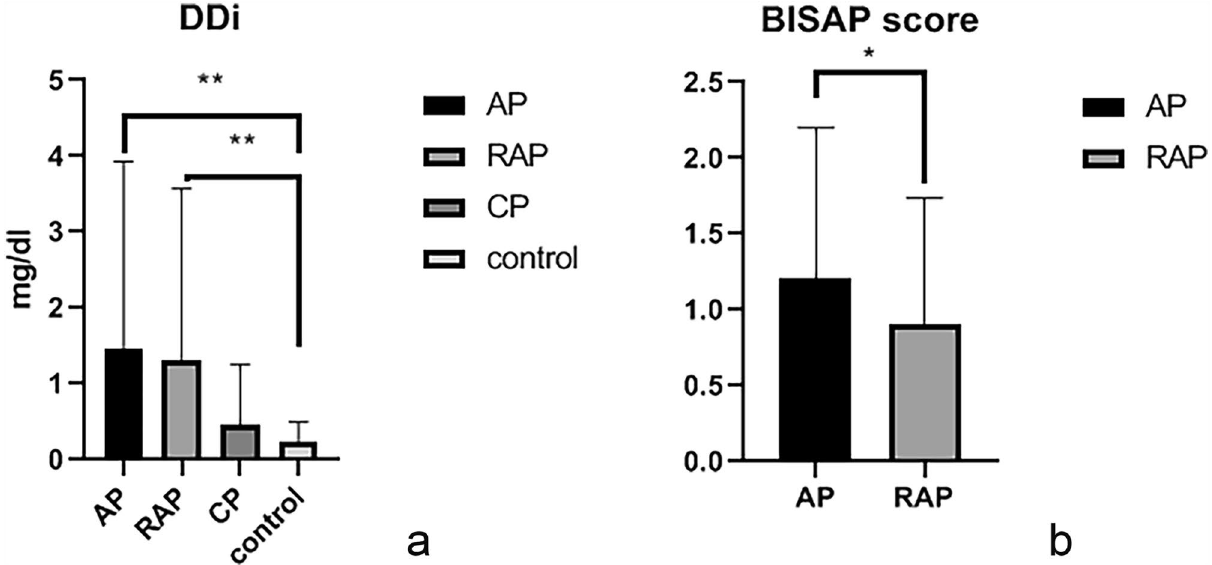
Figure 2. D-dimer level in different types of pancreatitis and severity of different types of pancreatitis: ( a ) D-dimer expression in types of pancreatitis. ( b ) BISAP score in different types of pancreatitis. *p < 0.05; **p <